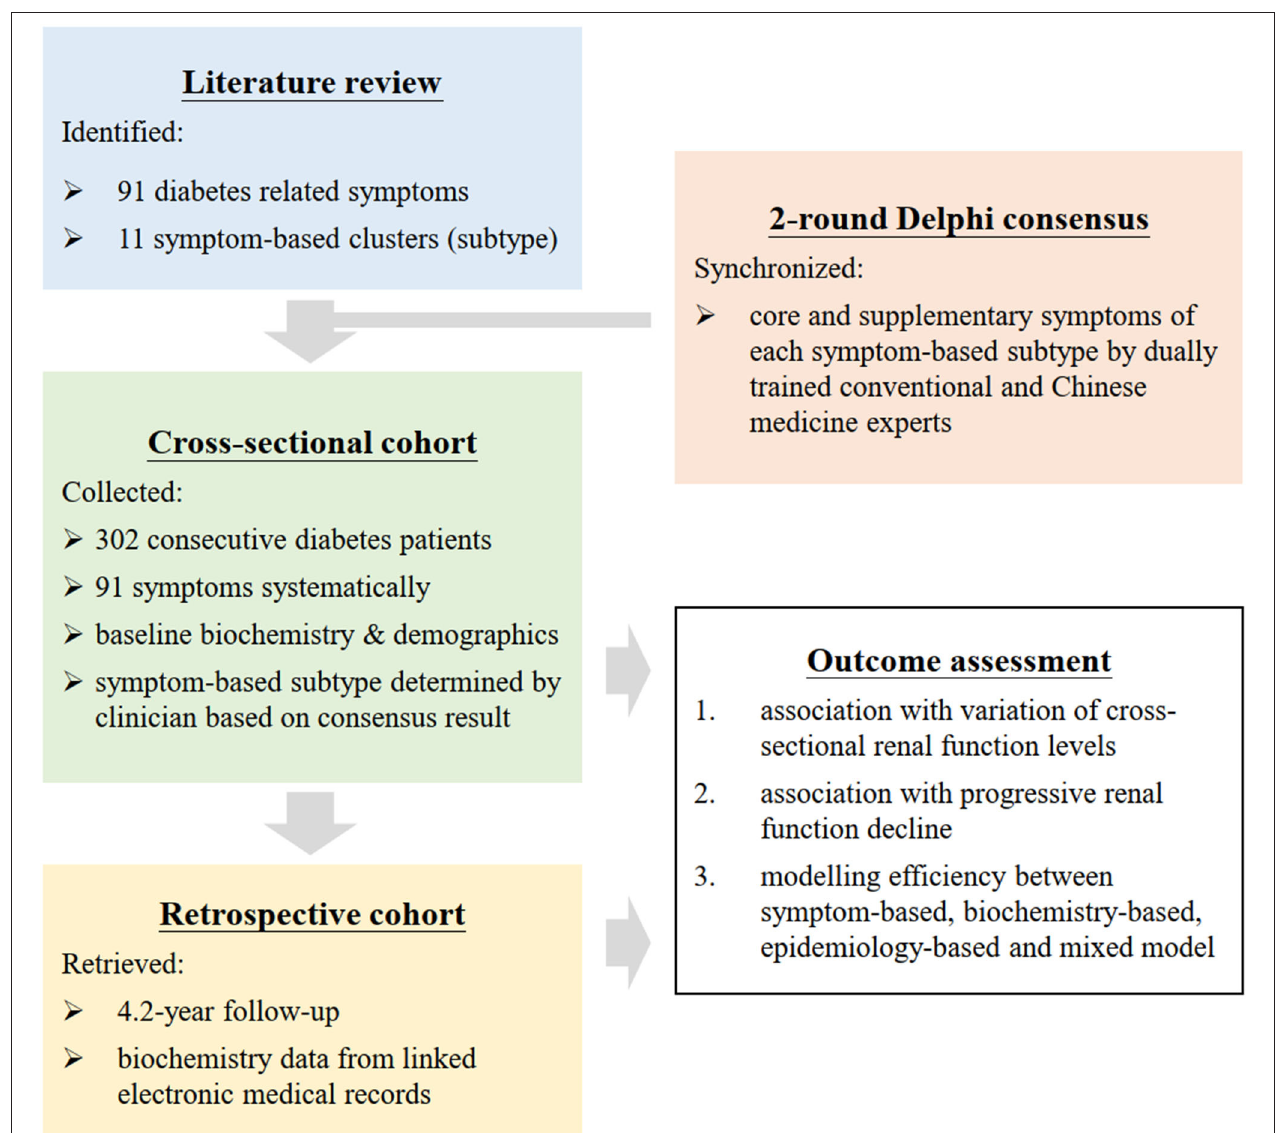
FIGURE 2 | Flow diagram of research. Symptoms of diabetes were analyzed as individual symptom and symptom clusters. Presence of 91 symptoms was recorded with field tested questionnaire by 2 synchronized physicians. Symptom clusters was constructed by extraction from literature followed by a consensus panel. The explanatory power and complexity of different models with combinations of symptoms, biochemistry, and demographics were compared by Akaike information criterion and Bayesian information criterion used in machine